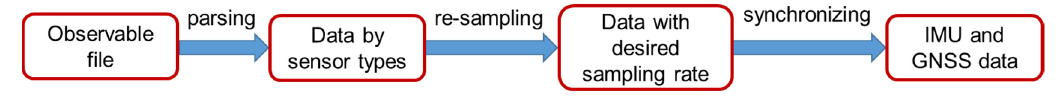
Figure 10. Smartphone data preprocessing steps.